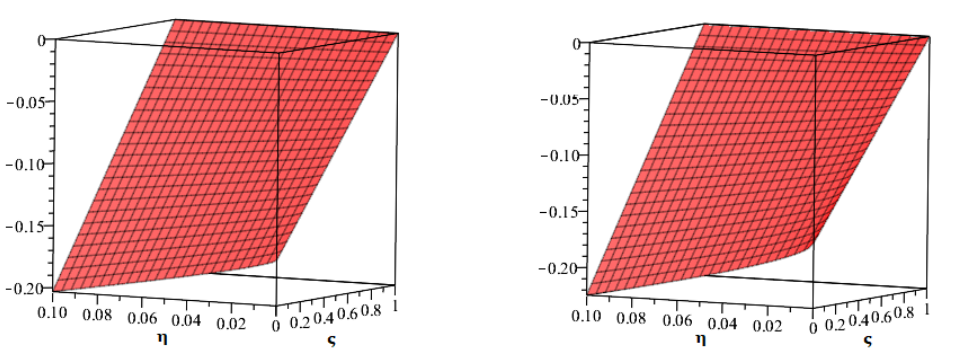
Figure 5. The proposed method solution at γ = 0.8,0.6 for example 2.